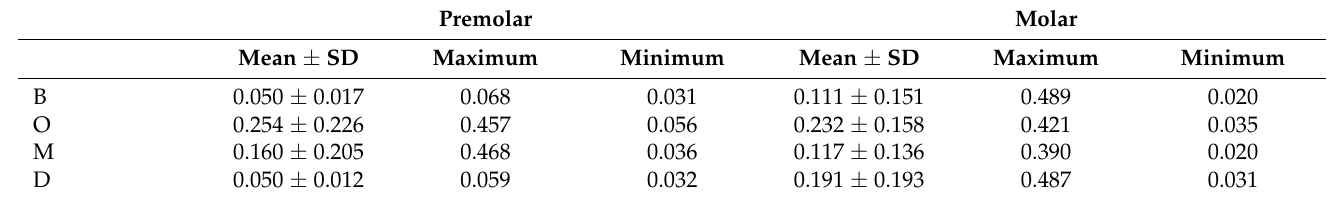
Table 3. Width of cracks on dental surfaces (mm), (B = buccal, O = oral, M = mesial, D = distal). Premolar Molar Mean ± SD Maximum Minimum Mean ± SD Maximum